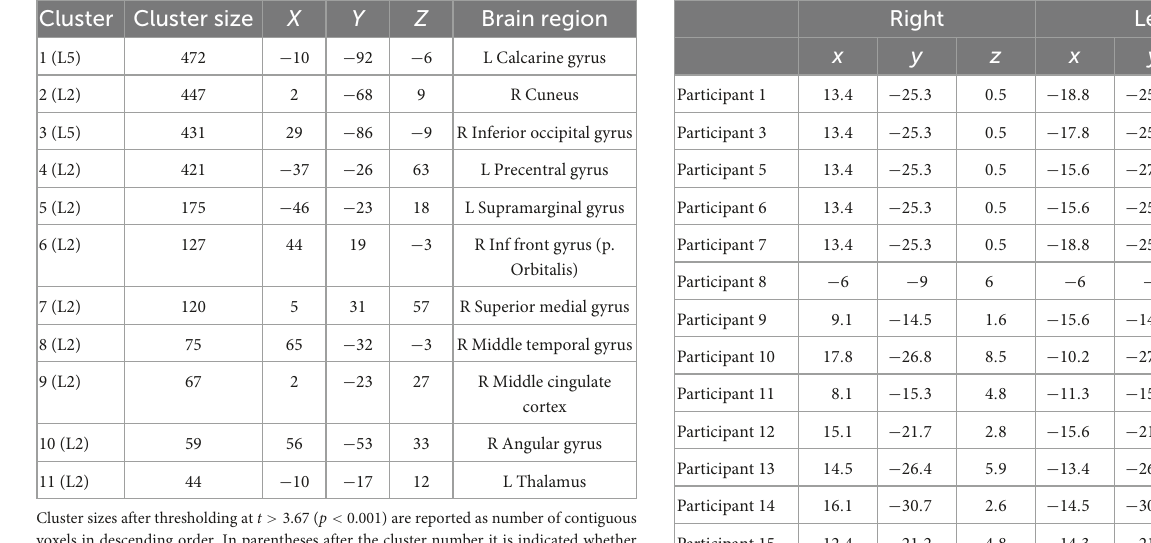
TABLE 2 Brain regions with significant differences between high and low load during the delay period. Cluster Cluster size X Y Z Brain region